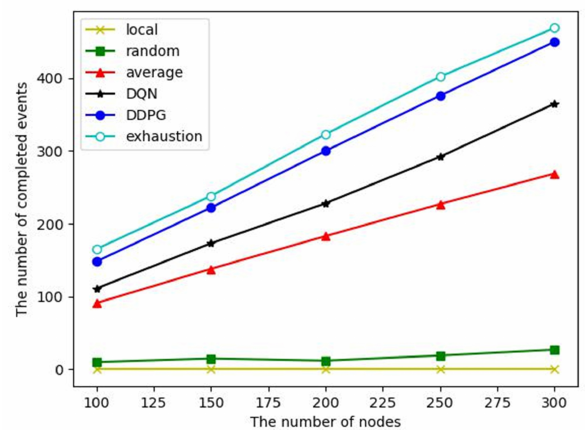
Figure 9. The number of completed events for a different number of nodes.